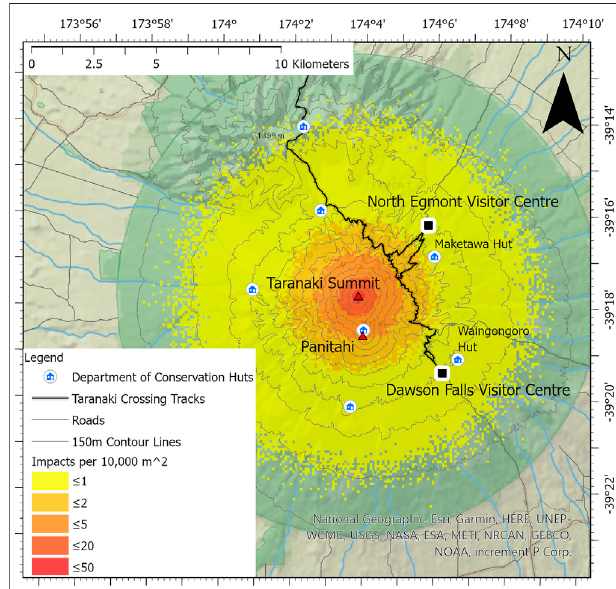
FIGURE 8 | Count of ballistic particle impacts per 10,000 ballistic particles with a diameter of 256 mm.